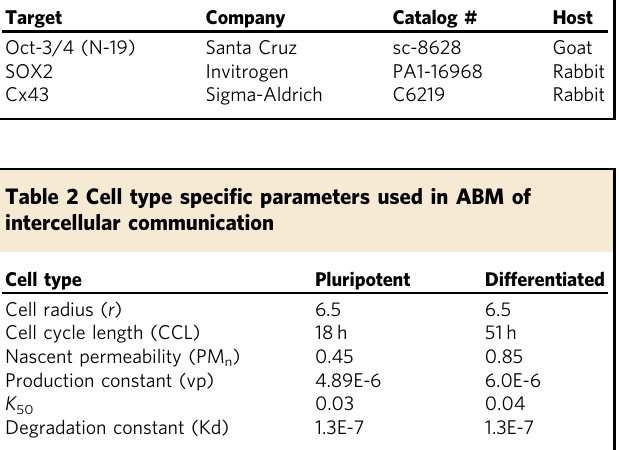
morphogenic events in vitro and successfully directing the emergence of desired engineered multicellular structures.